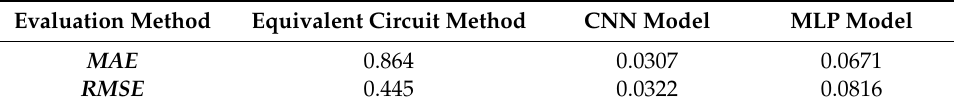
Table 4. Comparison between artificial intelligence and equivalent circuit